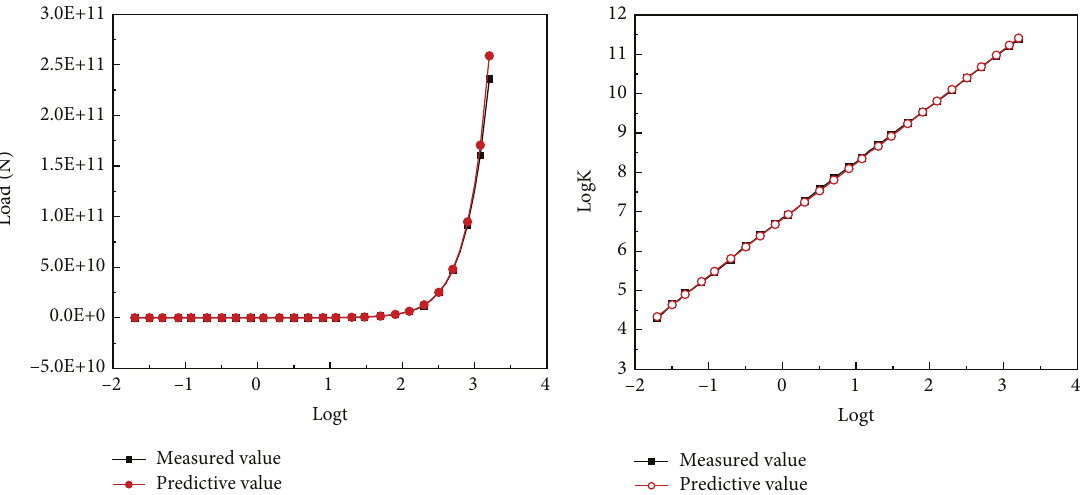
Figure 11: Prediction of ramp strain history data by relaxation modulus function.